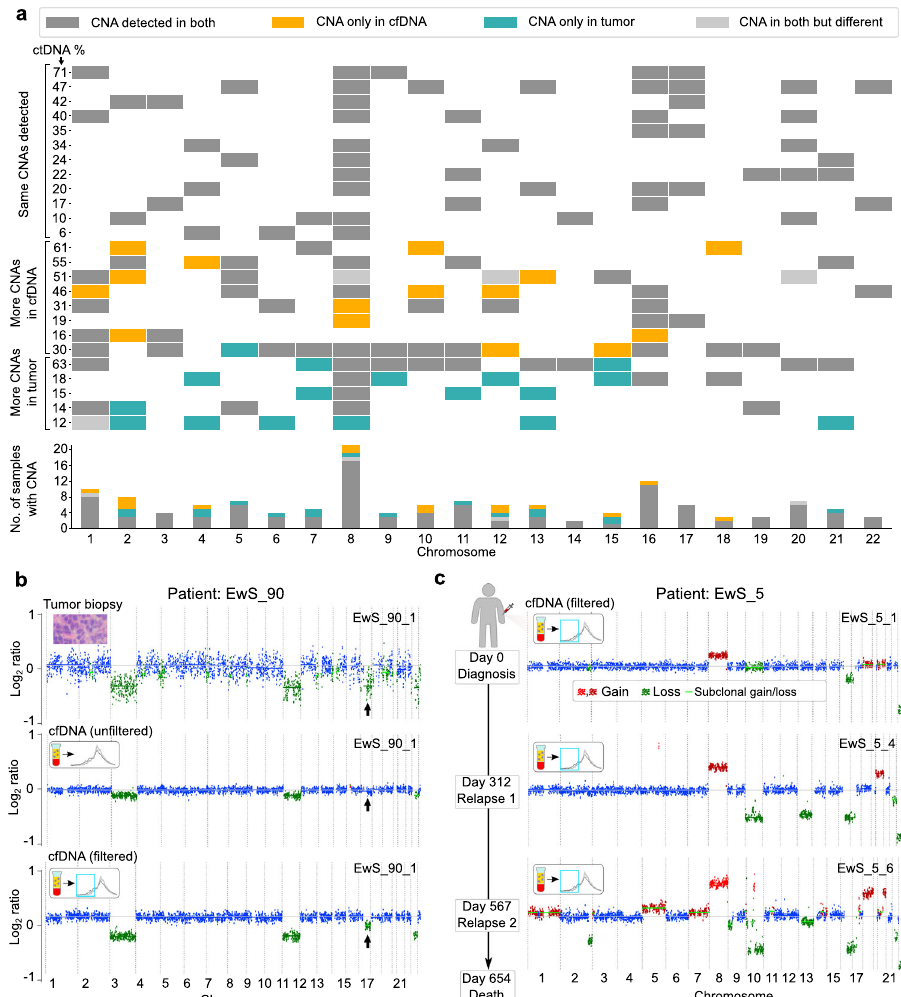
Fig. 3 CNA pro fi les in liquid biopsies re fl ect tumor aberrations and allow monitoring of tumor evolution. a Comparison of CNAs detected in cfDNA versus matched tumor biopsies. Only sample pairs with tumor-derived DNA detected in cfDNA based on ichorCNA are shown ( n = 29 sample pairs); four copy-number neutral sample pairs were omitted from the plot. Patients are grouped according to CNA state in cfDNA relative to the matched tumor biopsy. Gray represents CNAs detected in both cfDNA and matched tumor biopsy, orange indicates CNAs detected only in cfDNA, and turquoise represents CNAs detected only in the tumor biopsy. The CNAs detected in cfDNAs versus matched tumor biopsies are summarized in a bar plot (bottom). b CNA plot (ichorCNA) of an EwS cfDNA sample (EwS_90_1) before (middle) and after (bottom) in silico size selection to the range of 90 – 150 bp. A subclonal CNA on chromosome 16 (indicated by black arrows) that was clearly visible in the tumor biopsy (top) became detectable in the matched cfDNA sample only after in silico size selection. c CNA pro fi les (ichorCNA) of longitudinal cfDNA samples derived from the same patient (EwS_5) support the monitoring of somatic clonal evolution for individual patients. The fi ltered CNA pro fi les of samples collected at diagnosis and two subsequent relapses are shown. The day of sample collection relative to the day of diagnosis is indicated (left). Inferred chromosomal gains are shown in red, inferred deletions are shown in green, and CNA-neutral regions are shown in